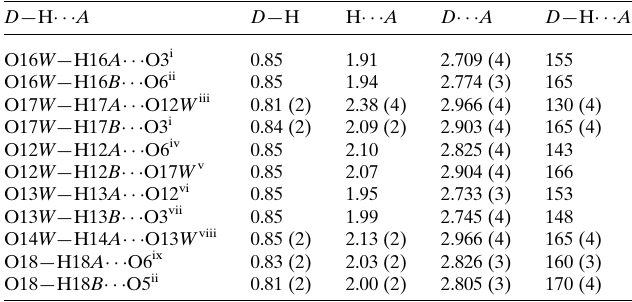
Table 2 Experimental details. Crystal data Chemical